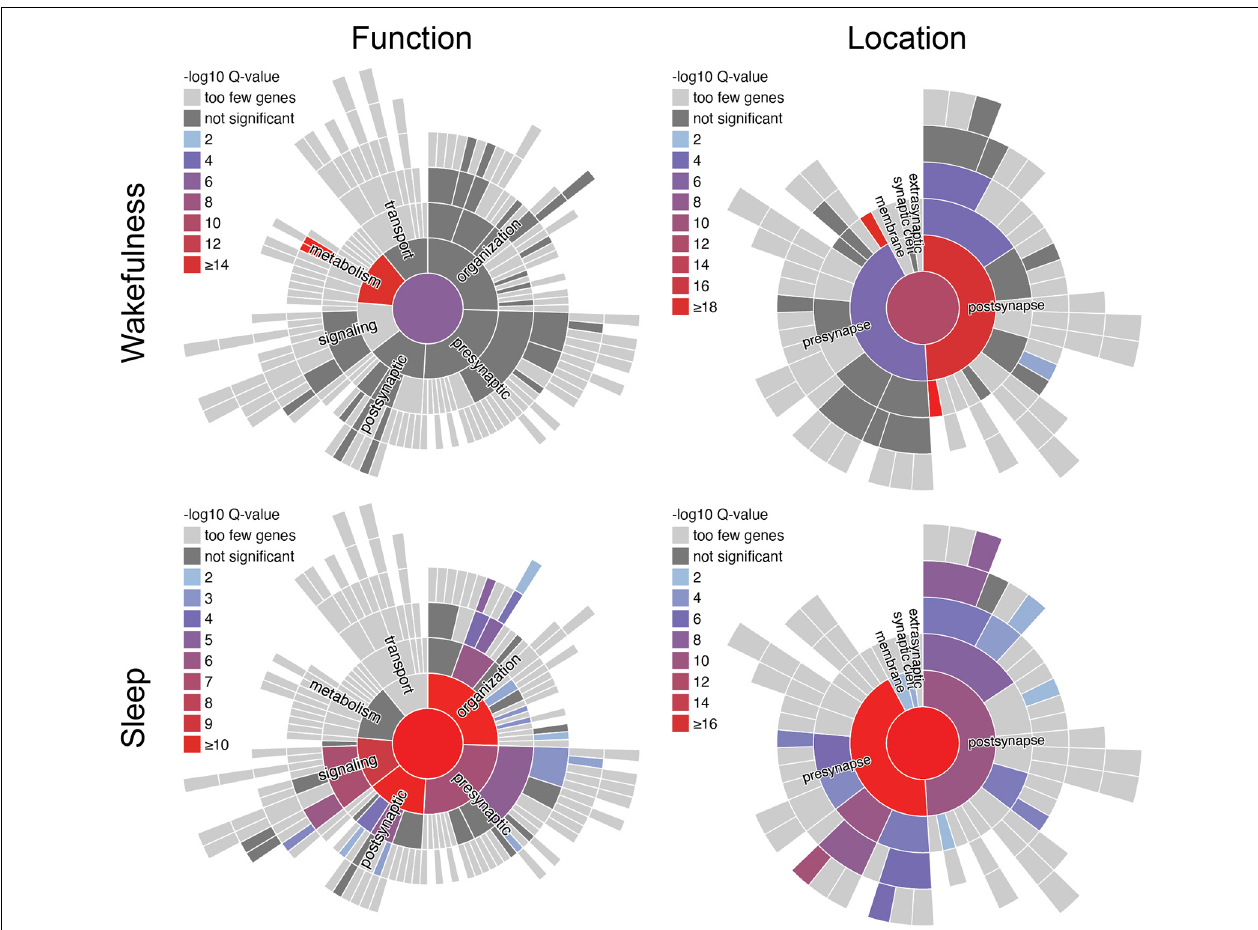
FIGURE 3 | SynGO analysis of synaptically enriched transcripts from murine forebrain synaptoneurosomes from Noya et al. (2019). Functional terms of synaptically enriched transcripts with peak expression during wakefulness (ZT12–24) are enriched for metabolic processes, whereas during sleep (ZT0–12) terms regarding synaptic function and structure are enriched. SynGO (version: 20210225) annotations are based on published experimental evidence and were peer reviewed by experts (Koopmans et al., 2019). Function- and location-terms are hierarchically ordered, with the highest hierarchical term (“function at the synapse”/“synapse”) in the center. One-hundred and seventy out of 1,354 synaptically enriched genes with peak expression during wakefulness and 155 out of 728 synaptically enriched genes with peak expression during sleep, respectively, were recognized and mapped to unique SynGO annotated genes. They were compared to the default background list provided by SynGO, which contains all genes expressed in the brain. Colors indicate the significance of enrichment compared to the background set. ZT, Zeitgeber